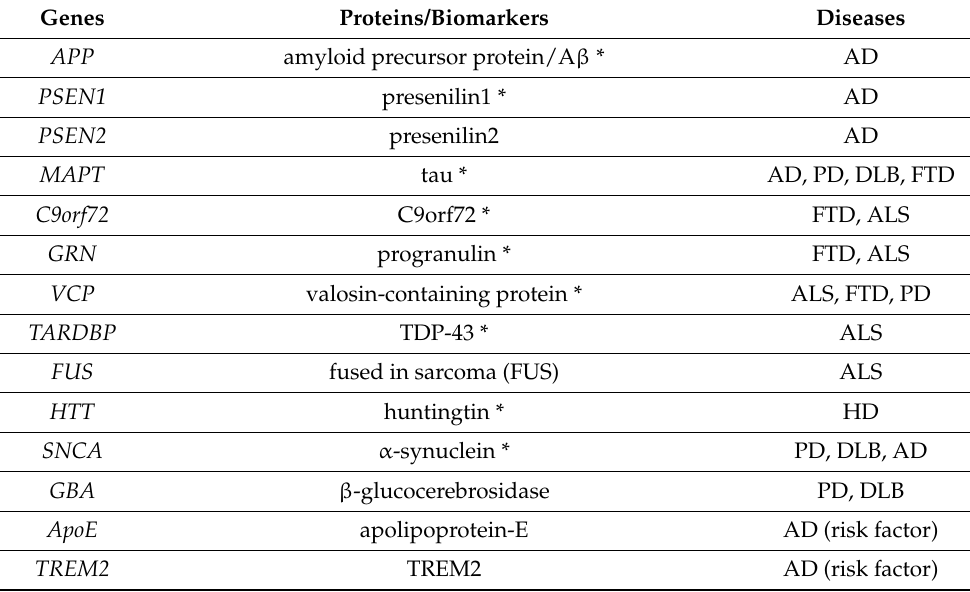
Table 1. Gene expression and disease specificity of proteins/biomarkers. Genes Proteins/Biomarkers Diseases APP amyloid precursor protein/A β * AD PSEN1 presenilin1 * AD PSEN2 presenilin2